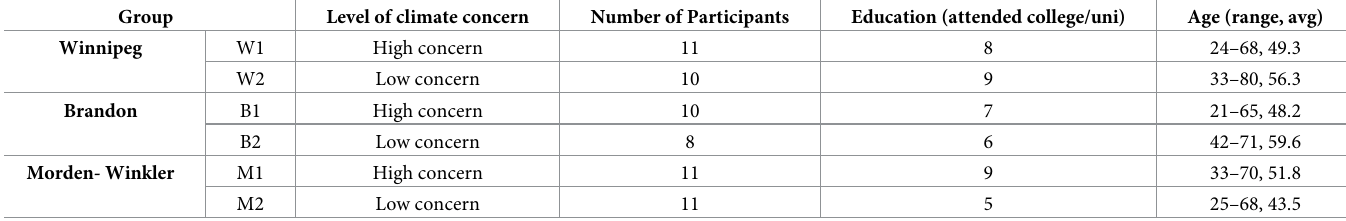
Table 1. Overview of focus group composition (n = 61). Full sociodemographic information of focus groups can be found in [33].